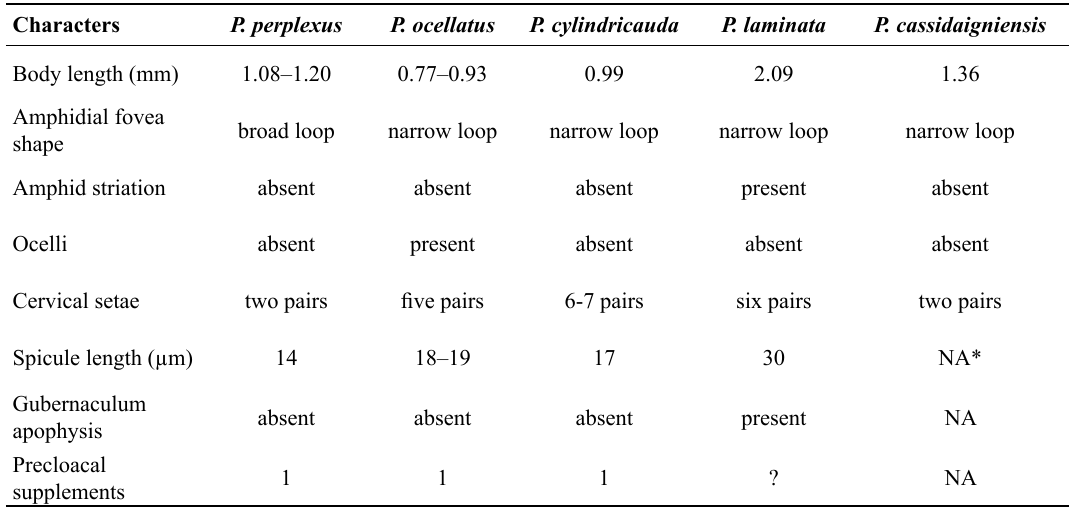
Table 3. Selected diagnostic characters of species of the genus Pseudaraeolaimus Chitwood, 1951 based on literature data supplemented with recent